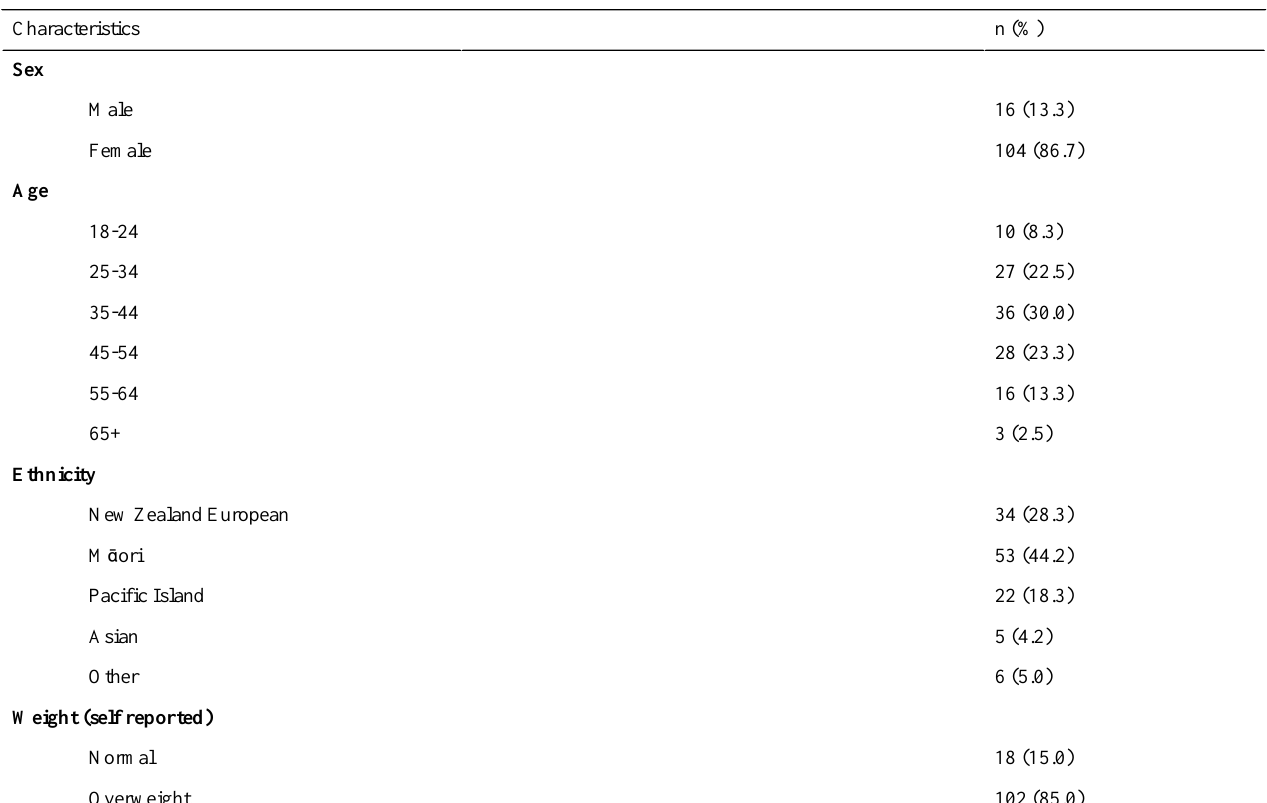
Table 2. Participant characteristics online survey (n=120).